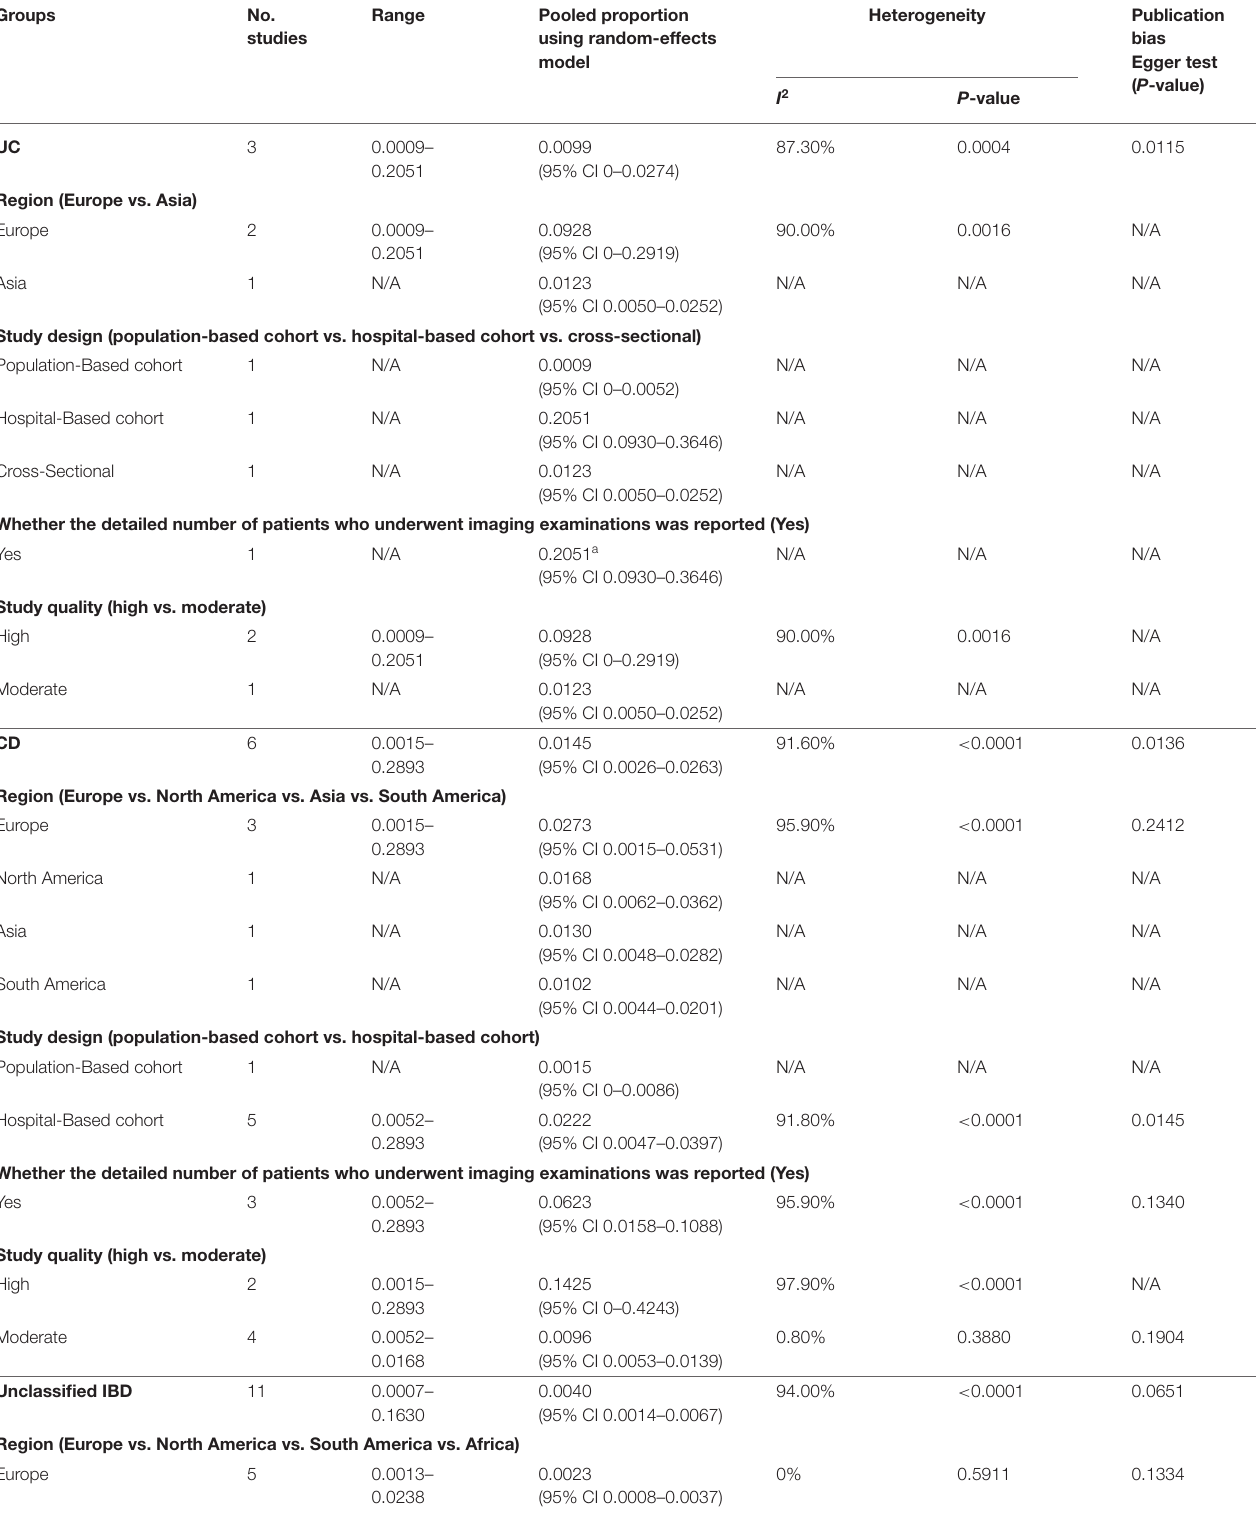
TABLE 2 | Prevalence of PVST in patients with IBD in whom the information with respect to colorectal surgery was unclear.